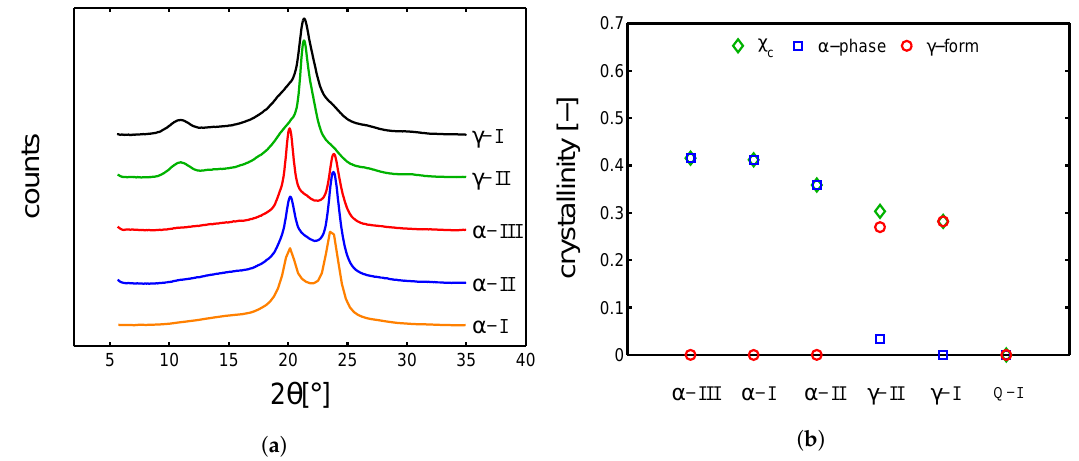
Figure 2. ( a ) wide angle X-ray diffraction integrated patterns; ( b ) deconvolution analysis of all the investigated samples with different thermal histories (dry state).